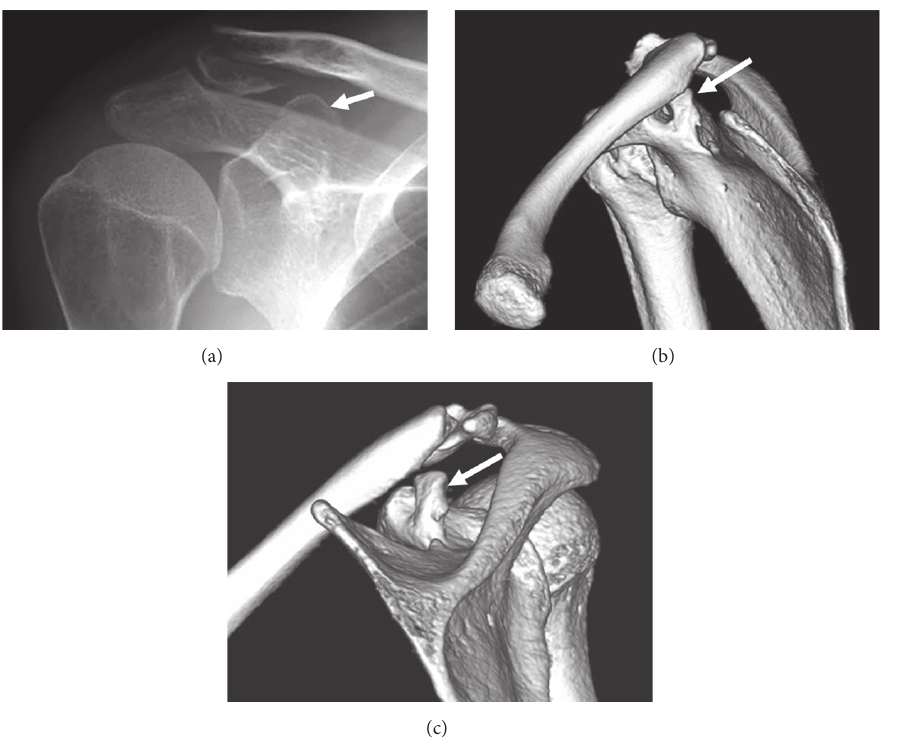
Figure 3: Imaging of Case 3. (a) Radiogram taken at the first visit revealing distal clavicular fracture (type 2b according to Craig’s classification) and avulsion fracture of the posterior side of the coracoid process (arrow). (b and c) Three-dimensional computed tomography taken 1 year after the injury demonstrating nonunion of the lateral clavicular fracture and the malunited coracoid fragment migrating posterosuperiorly